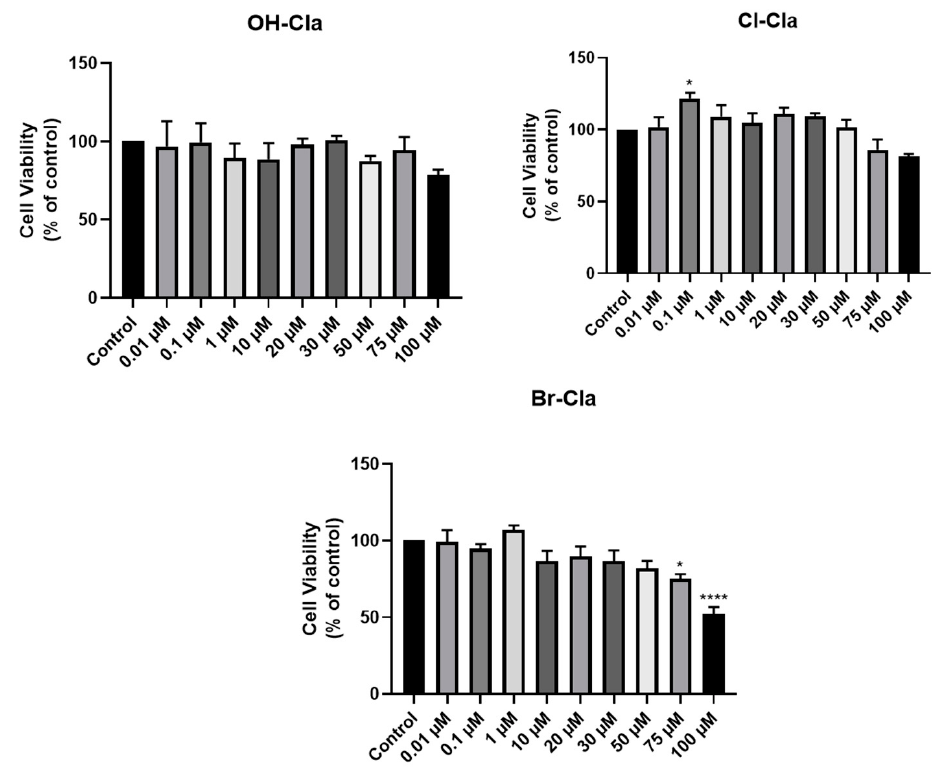
Figure 6. Effects of OH-, Cl-, and Br-Cla on SH-SY5Y cellular viability. Cells were cultivated in the presence of increasing concentrations of each compound. After 48 h, an MTT assay was performed to measured cellular viability. Results are presented as mean ± SEM. * Statistically significant vs. control at p < 0.05; **** statistically significant vs. control at p < 0.0001.